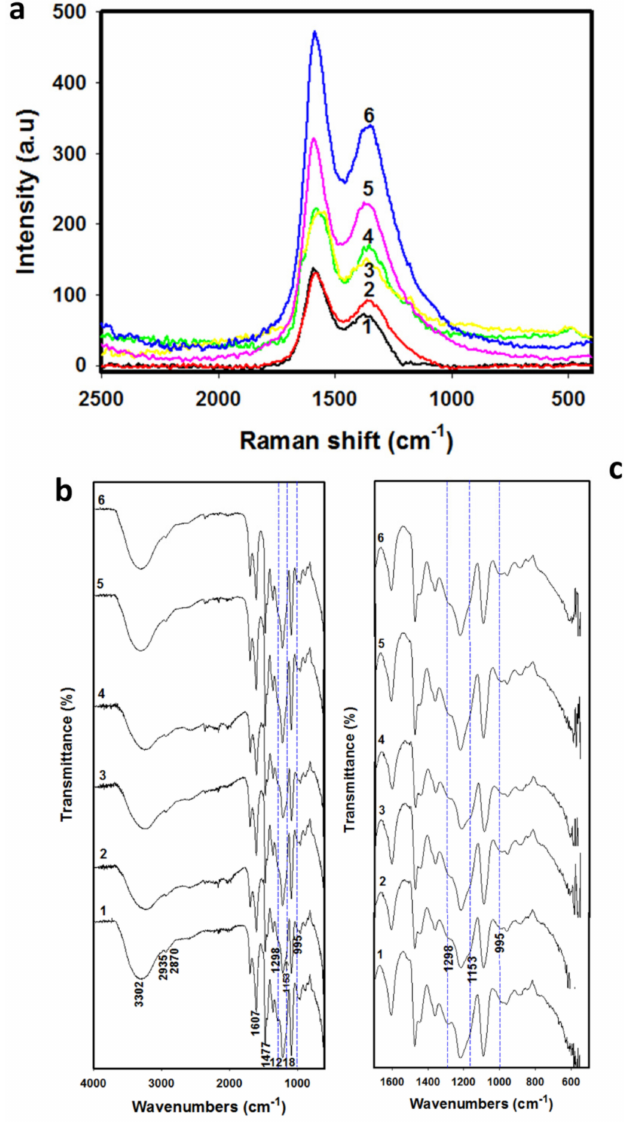
Figure 1. ( a ) Raman and ( b , c ) FTIR spectra of Cs–RFX hybrid samples RFX–Cs-0 through RFX–Cs-5 (curves 1 through 6, respectively). FTIR spectra in figure ( b ) range from 4000–400 cm − 1 and in subfigure ( c ) range from 1700–500 cm − 1